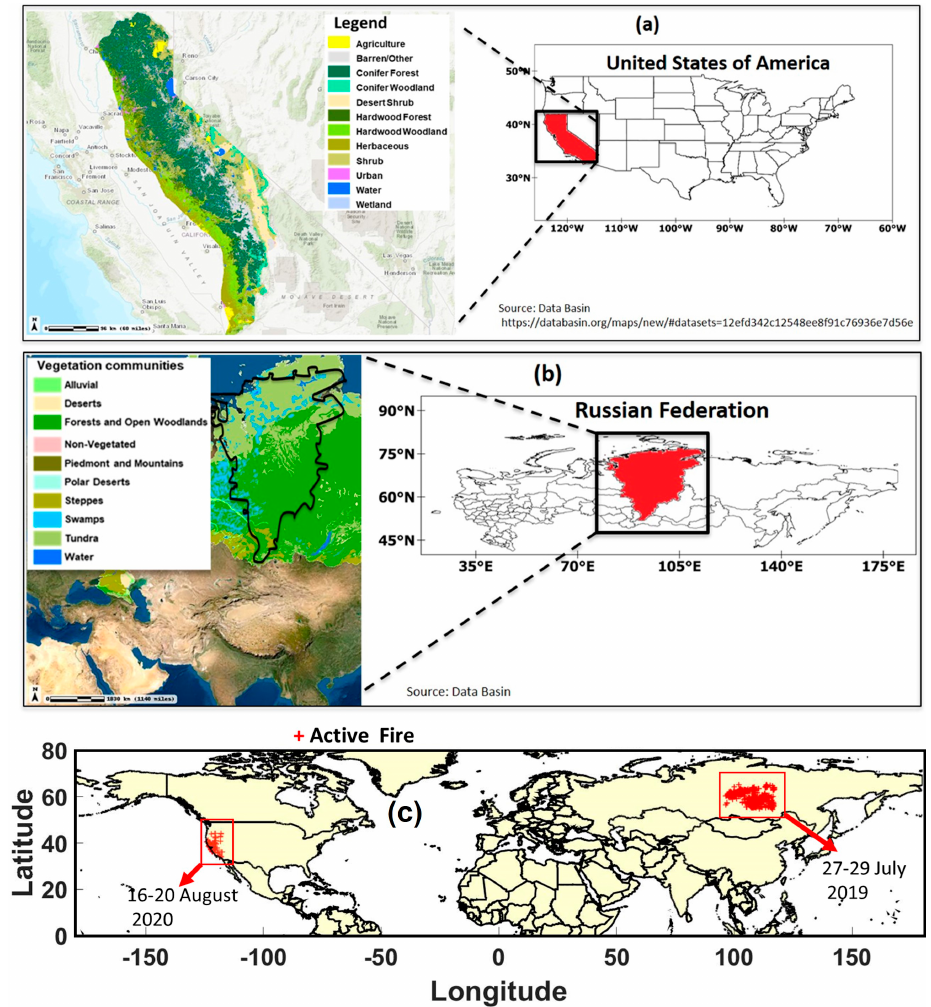
Figure 1. A map showing the land cover in ( a ) California (United States of America) and ( b ) Krasnoyarsk Krai (Russian Federation). ( c ) Fire map showing active fires in California (16–20 August 2020) and Krasnoyarsk Krai (27–29 July 2019).